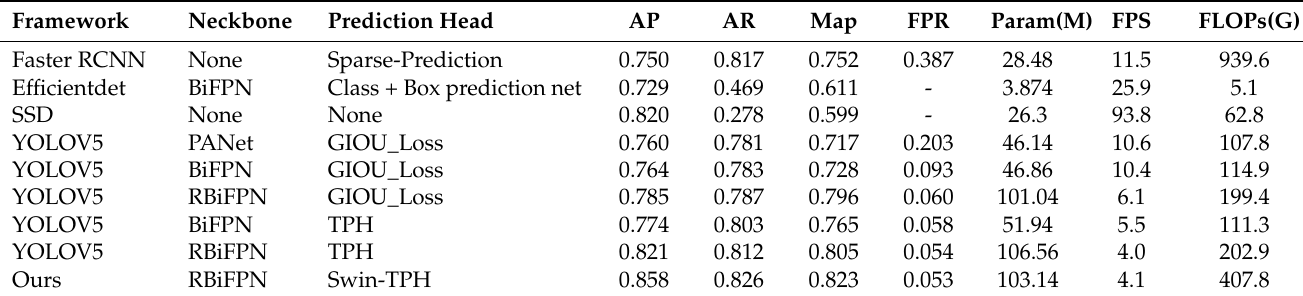
Table 4. Comparison of precision and recall of fire smoke